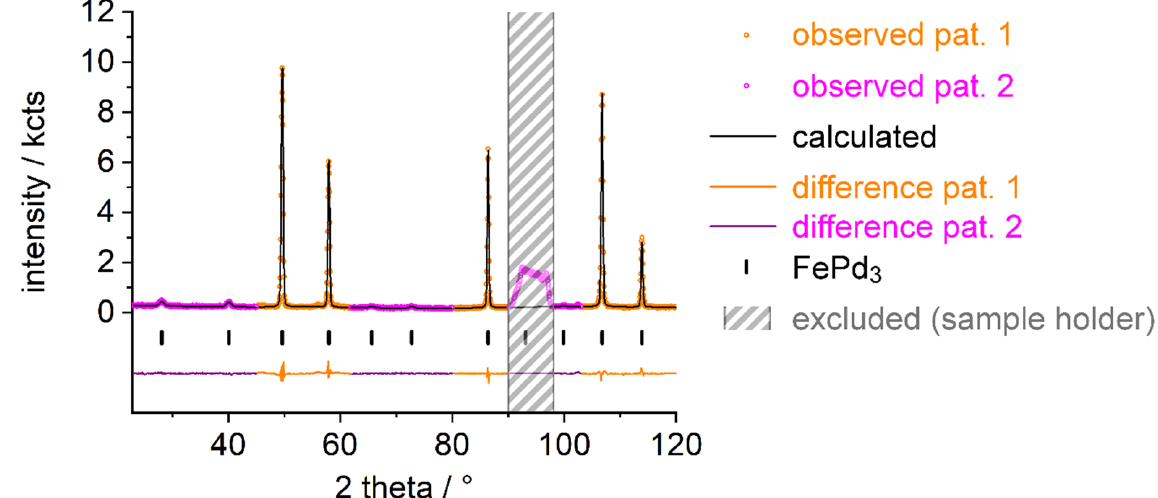
Figure A26. Rietveld refinement of the crystal structure of FePd 3 D 0.058(9) (for details, see fourteenth row in Tables A8 and A9) based on neutron powder diffraction data (NUMOR 131859 [21], λ = 186.80(2) pm, D20 ILL, Grenoble) in a single-crystal sapphire cell at 384(1) K and 8.14(1) MPa deuterium pressure using FullProf [24].